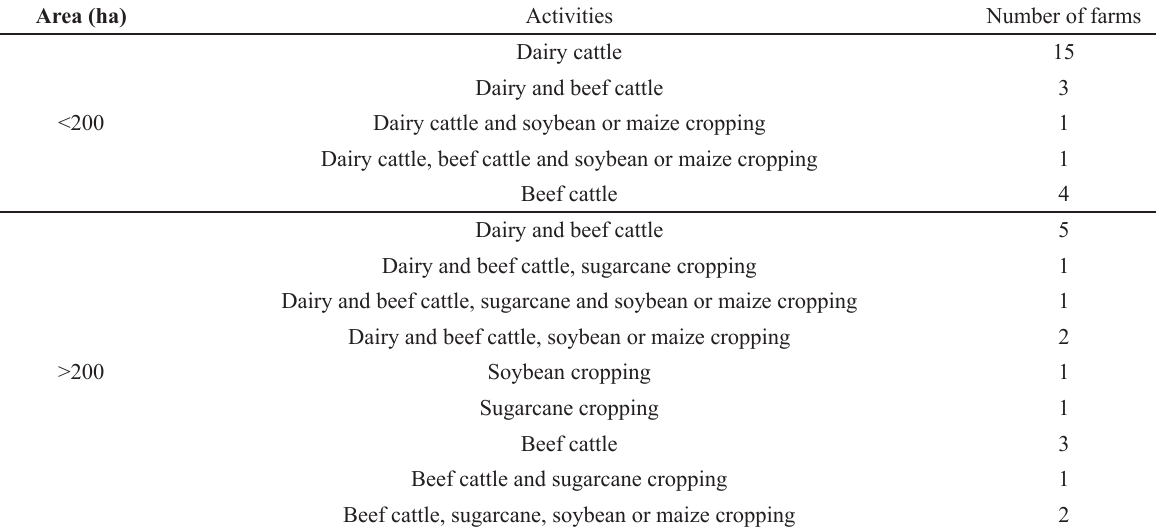
Area and agricultural activities of the interviewed farmers in the counties of Quirinópolis and Gouvelândia, Goiás, Brazil (n = 41, area = 20,918